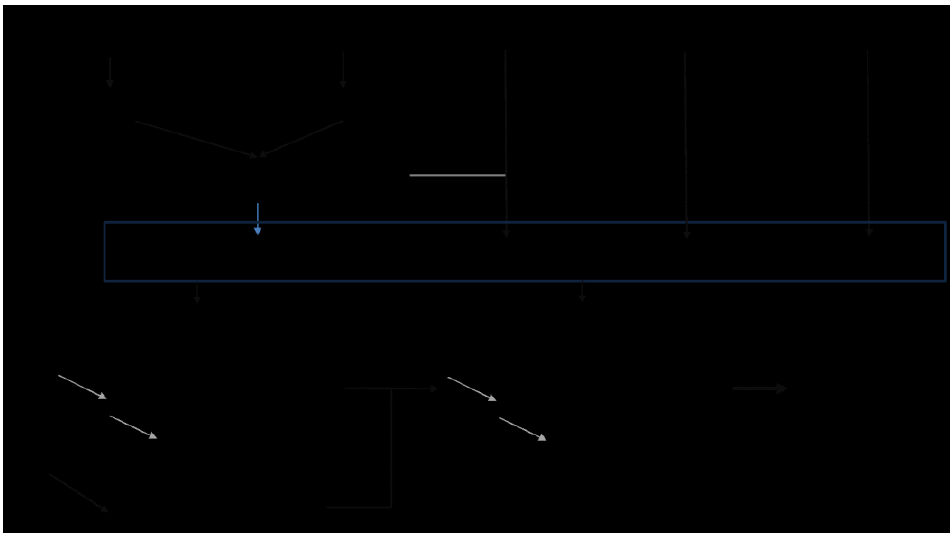
Figure 3. Processing steps for urban growth